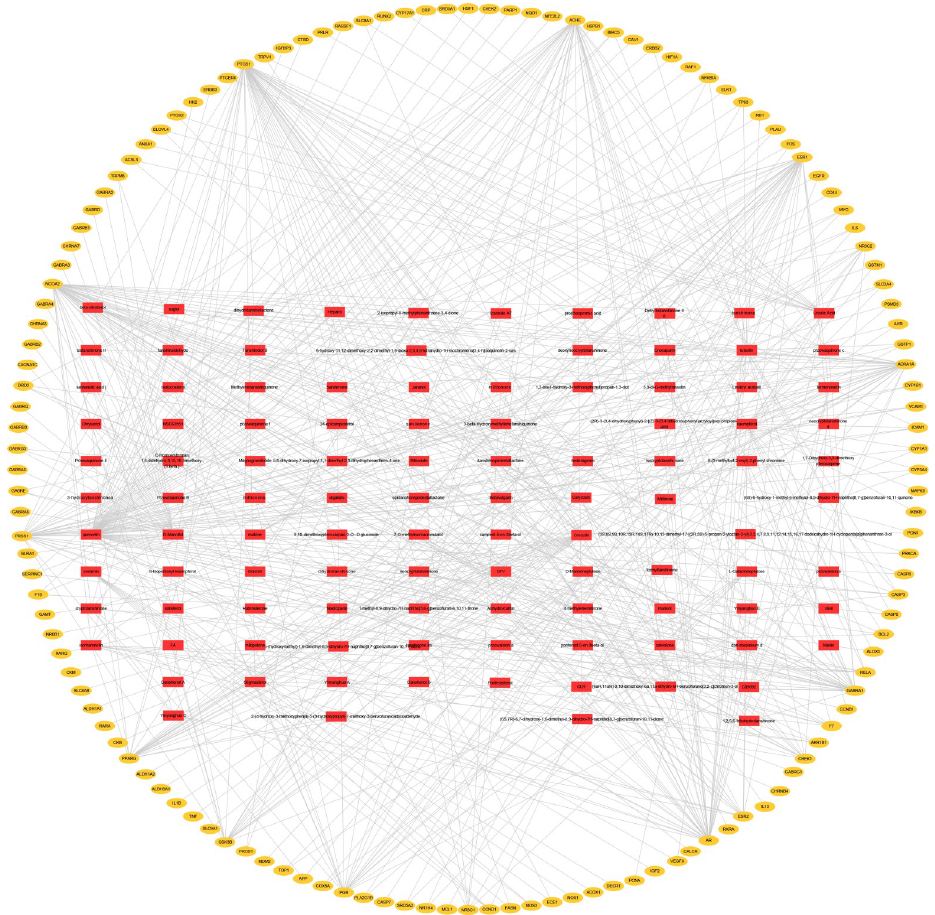
Fig 3. Compound-target network of YSTLF. Red rectangles represent the compounds in YSTLF, and orange circles represent the targets of oligoasthenozoospermia.